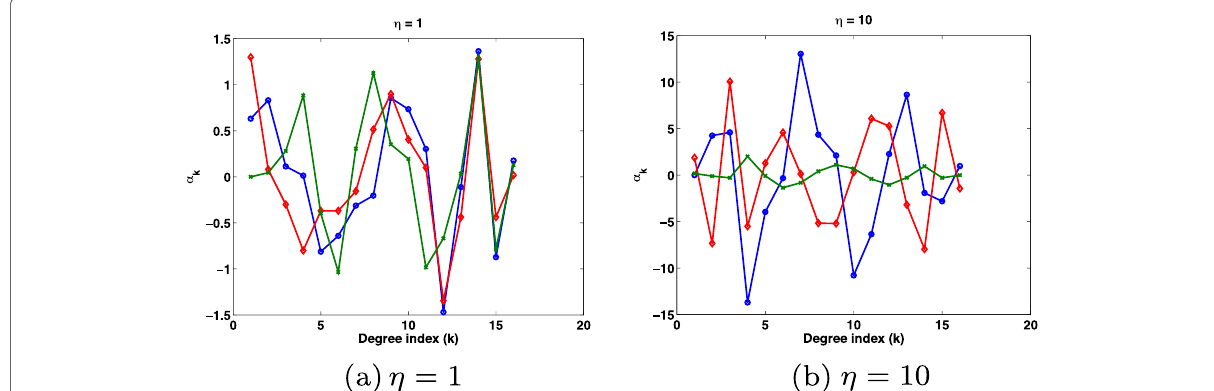
Fig. 3 Polynomial coefficient values, for each of the dictionary kernels, for different values of η in solving the optimization problem (20). ( a ) η = 1. ( b ) η =